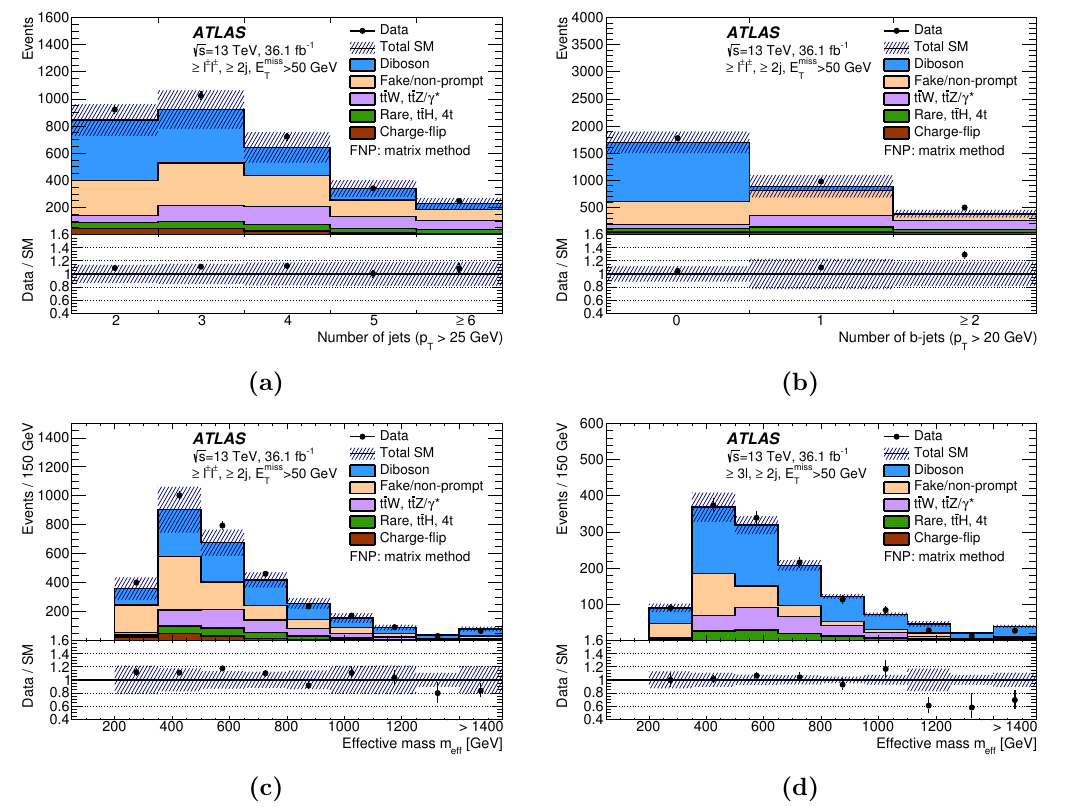
Figure 2. Distributions of (a) the number of jets, (b) the number of b -tagged jets and (c), (d) the e(cid:11)ective mass. The distributions are made after requiring at least two jets ( p T > 40 GeV) and E miss > 50 GeV, as well as at least two same-sign leptons (a, b, c) or three leptons (d). The T uncertainty bands include the statistical uncertainties for the background prediction as well as the systematic uncertainties for fake- or non-prompt-lepton backgrounds (using the matrix method) and charge-(cid:13)ip electrons. Not included are theoretical uncertainties in the irreducible background contributions. The rare category is de(cid:12)ned in the